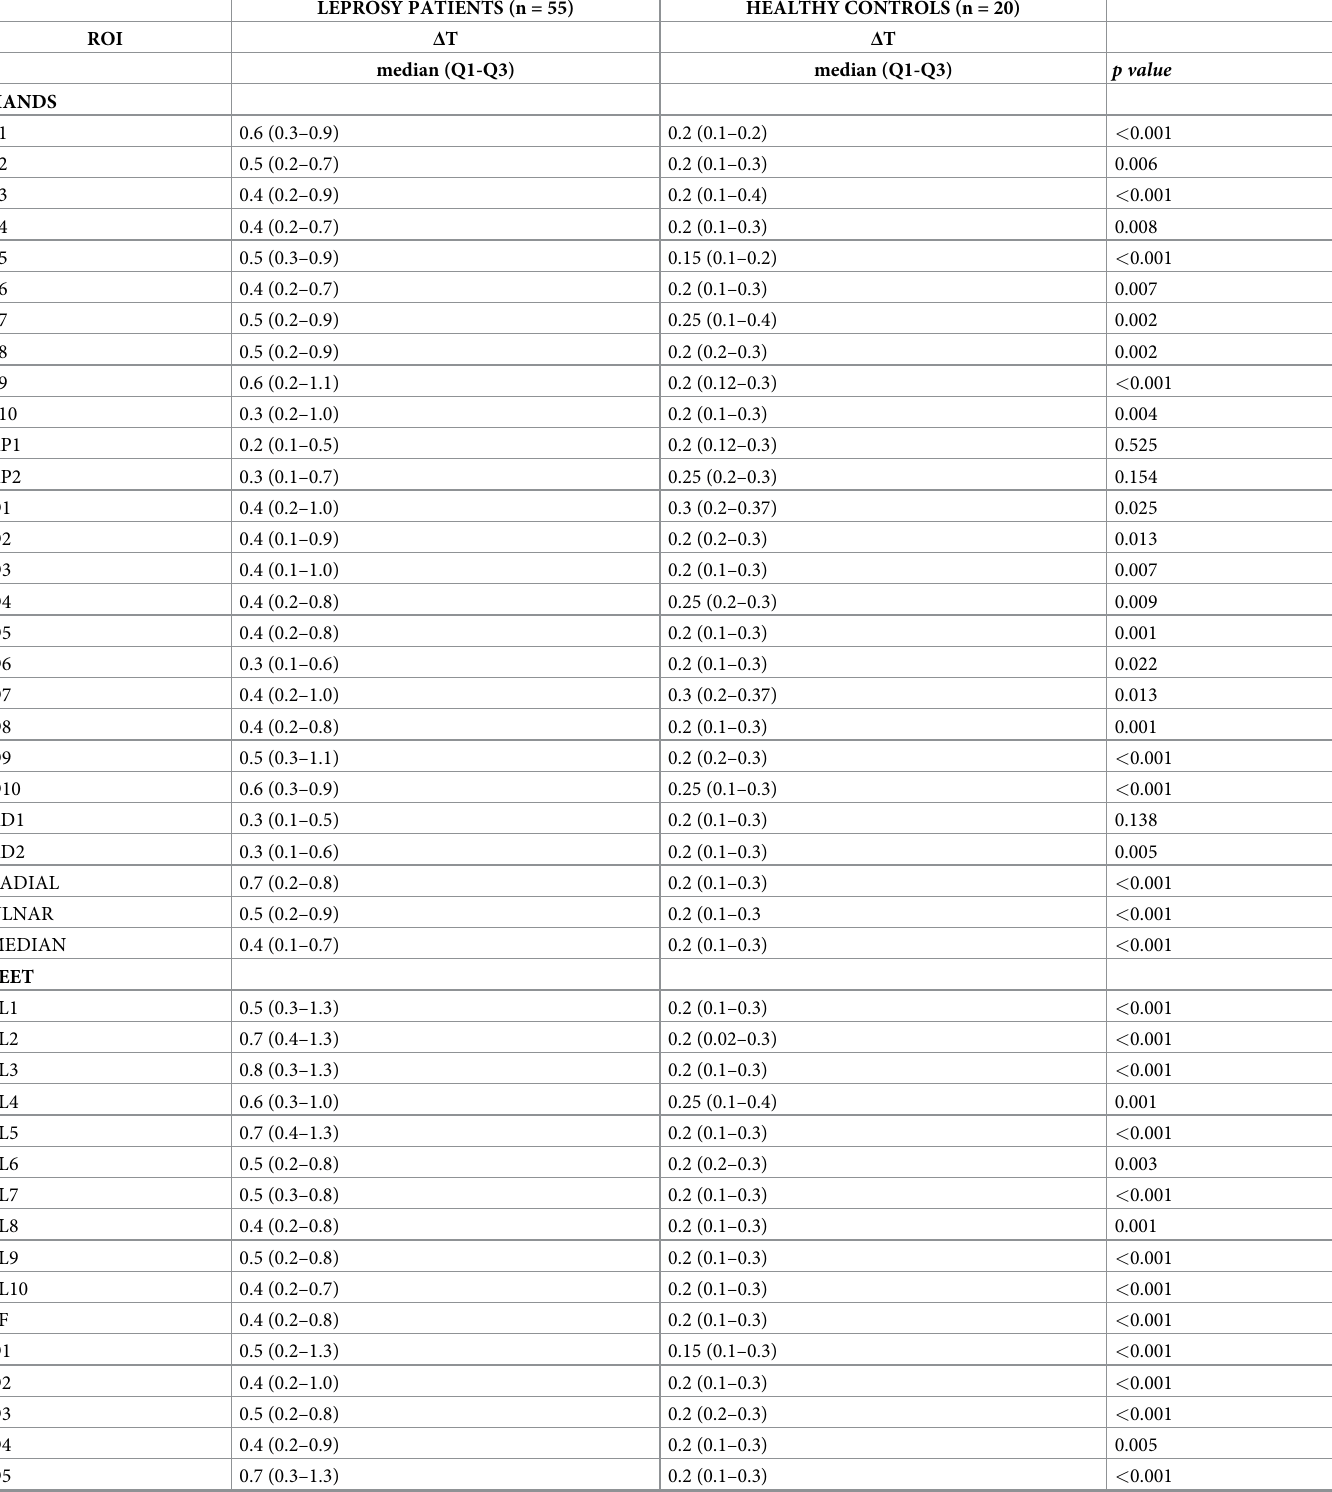
Table 2. Comparison of Δ T in ROIs and neural areas of the hands between the group of patients and healthy